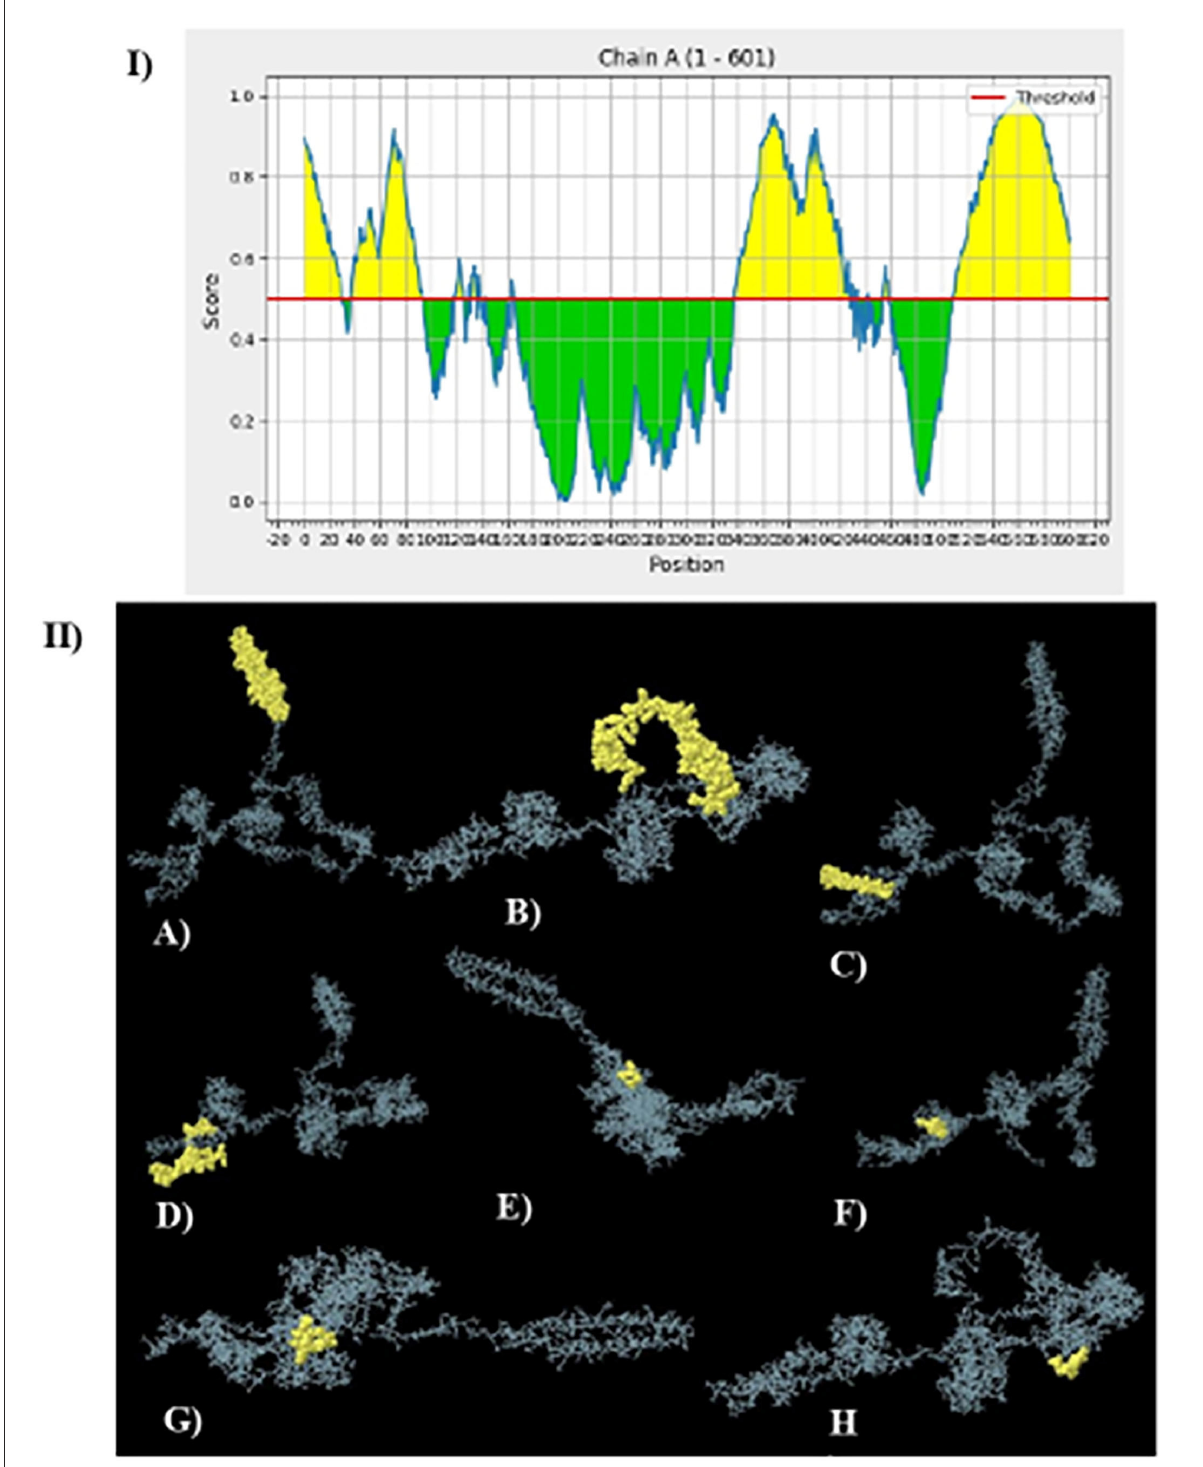
FIGURE8 The ElliPro server of IEBD database for the prediction of eleven conformational B-cell epitopes: (I) Position of conformational B-cell epitopes 2D illustration. (II) 3D models of B-cells epitopes where yellow spheres present the conformational B-cell epitopes. (A) 35 residues with a score of 0.819 (B) 155 residues with a score of 0.819 (C) 42 residues with a score of 0.802 (D) 10 residues with a score of 0.675 (E) 13 residues with a score of 0.634 (F) 51 residues with a score of 0.615 (G) 9 residues with a score of 0.612 (H) 11 residues with a score of